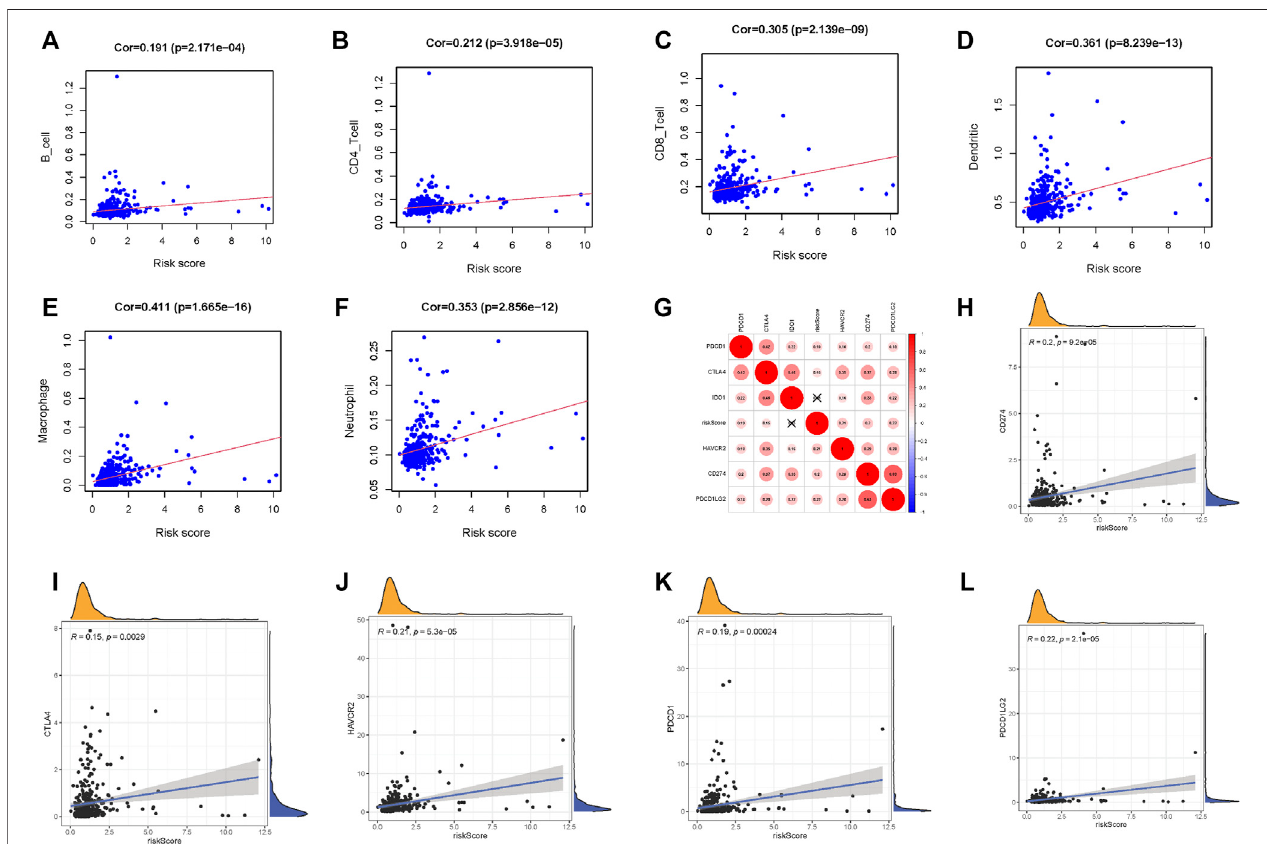
FIGURE 6 | Correlation between tumor immune in fi ltration and this immune-related lncRNA signature. (A) Association between this signature and B cells. (B) AssociationbetweenthissignatureandCD4 + Tcells. (C) AssociationbetweenthissignatureandCD8 + Tcells. (D) Associationbetweenthissignatureanddendriticcells. (E) Association between this signature and macrophages cells. (F) Association between this signature and neutrophil cells. (G) Association analyses between immune checkpoint inhibitors CD274, PDCD1, PDCD1LG2, CTLA4, HAVCR2, and IDO1 and lncRNAs signature. (H) Association between our risk model and CD274. (I) Association between our risk model and CTLA4. (J) Association between our risk model and HAVCR2. (K) Association between our risk model and PDCD1. (L) Association between our risk model and PDCD1LG2.